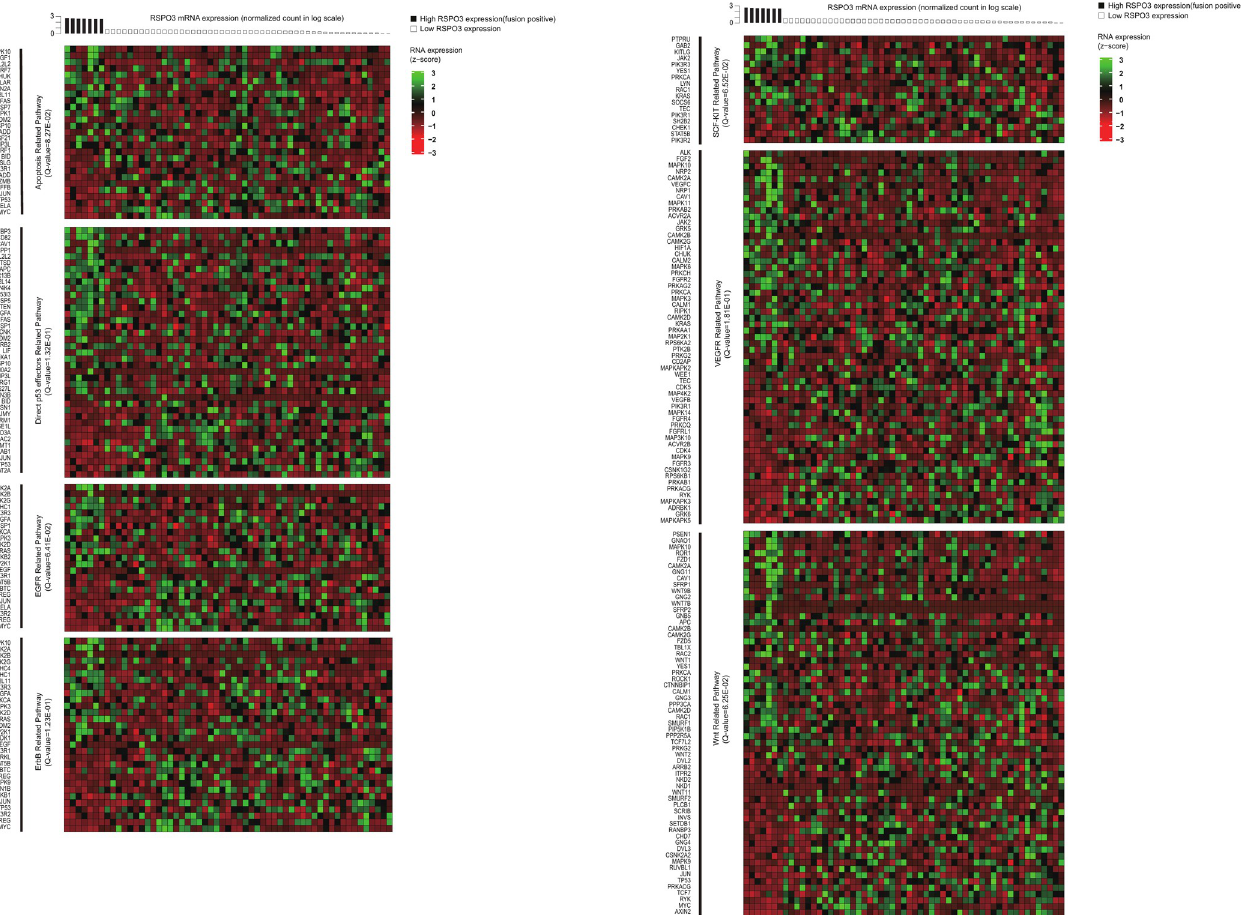
Fig 1. Gene expression heatmap of 7 cancer-related pathways enriched with genes that were correlated to RSPO3 in RNA expression. A total of 256 genes associated with Apoptosis, Direct p53, EGFR, ErbB, SCF-KIT, VEGFR, WNT signaling showed significant differences in expression between RSPO3 fusion- positive colorectal samples and the control samples (see details in Methods). The RNA expression was transformed to z-score. The x-axis represents the sample, and the y-axis represents the RNA expression.